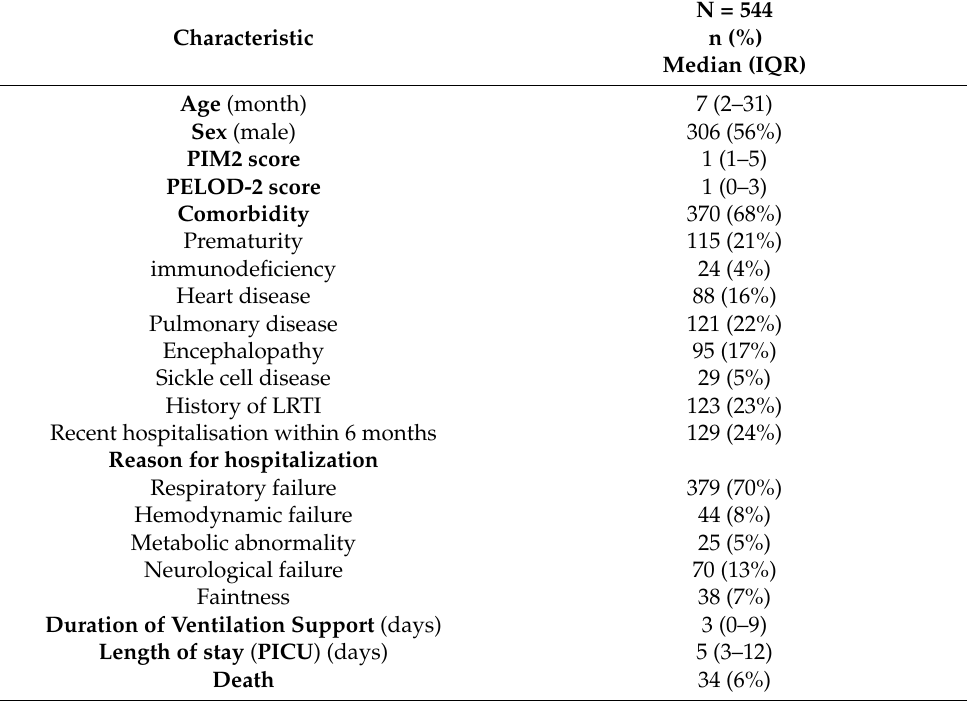
Table 1. Characteristics of patients corresponding to each FilmArray ® Respiratory Panel